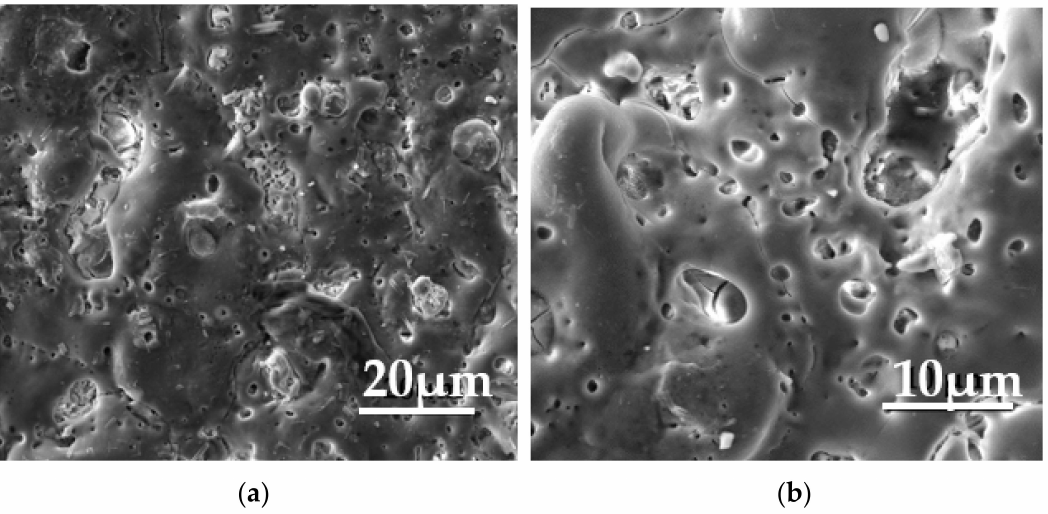
Figure 5. SEM images of PExO coating surface morphology, ( a ) SEM magnification 5000 × , ( b ) SEM magnification 10,000 ×